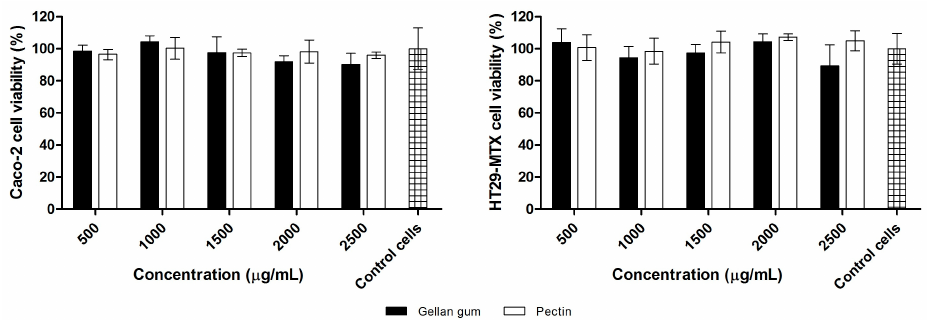
Figure 3. Cell viability (%) of Caco-2 and HT29-MTX cell lines after 24 h of incubation with increasing concentrations (500–2500 μ g/mL) of GG and P (mean ± SD).